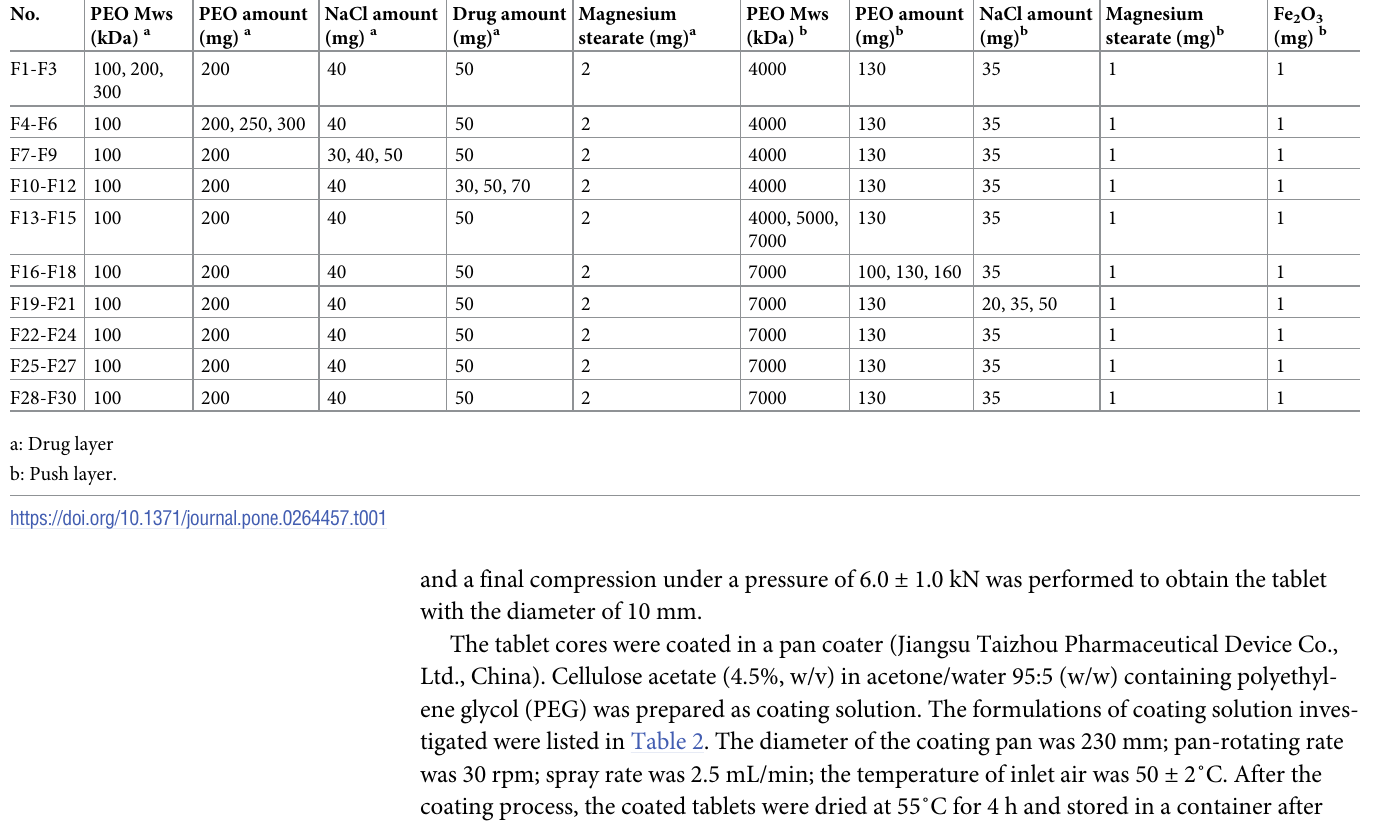
Table 1. Core tablet formulations and levels used in the single-factor experiments.